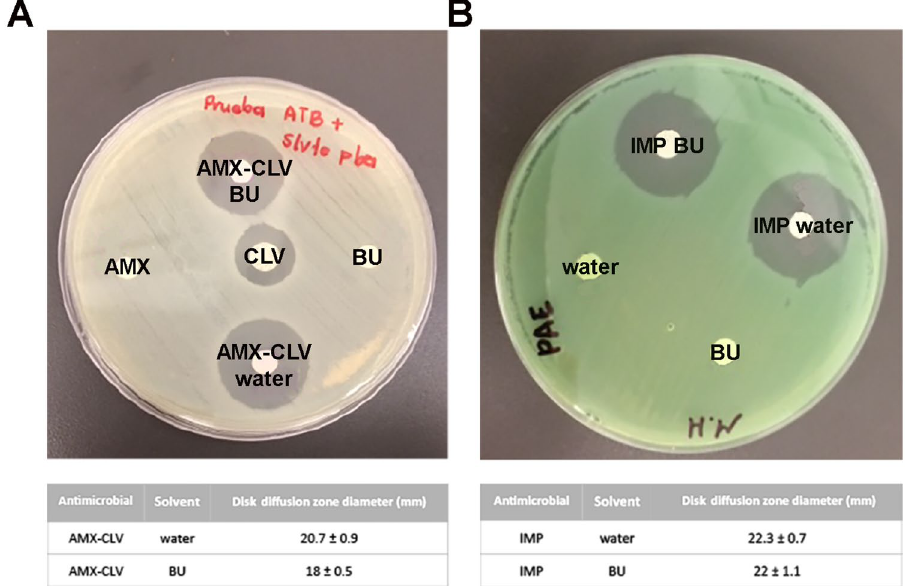
Figure 8. Representative inhibition zone assay on Escherichia coli ATCC-35218 cultures using membrane disks loaded with clavulanic acid together with amoxicillin in water solution (AMX-CLV water); amoxicillin clavulanic acid in BU solutions (AMX-CLV BU) and clavulanic acid (CLV), amoxicillin (AMX) and BU membrane disks as controls ( A ). Representative inhibition zone assay on Pseudomonas aeruginosa ATCC-27853 cultures using membrane disks loaded with imipenem in water solution (IMP water); imipenem in BU solutions (IMP BU) and BU membrane disks as control. Results are expressed as median ± SEM of three experimental